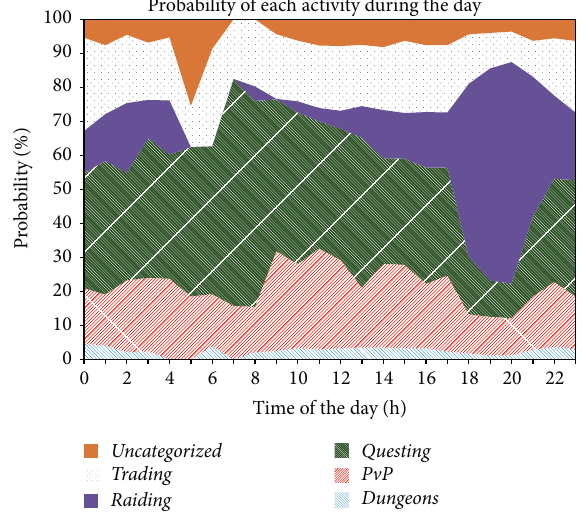
Figure 4: Daily pattern of players’ activities. Table 2: Popularity of arena brackets.